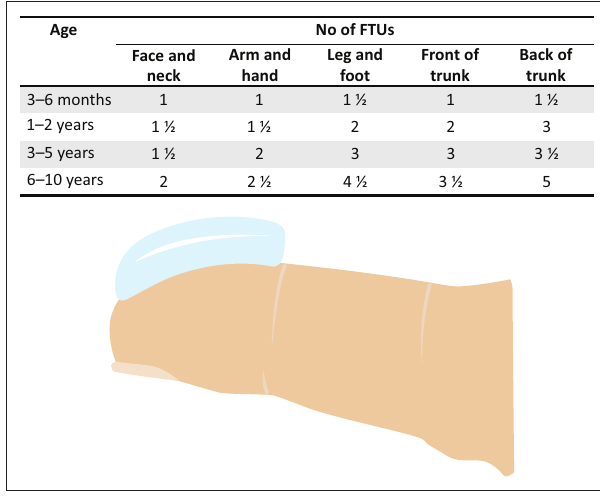
FTU, fingertip unit. FIGURE 2: ‘The fingertip method’. The amount of fingertip units (the amount of ointment or cream covering the area on the finger from skin-crease to the tip of an adult’s index finger) required for steroid application depends on the age of the child and the specific body area that needs to be treated.